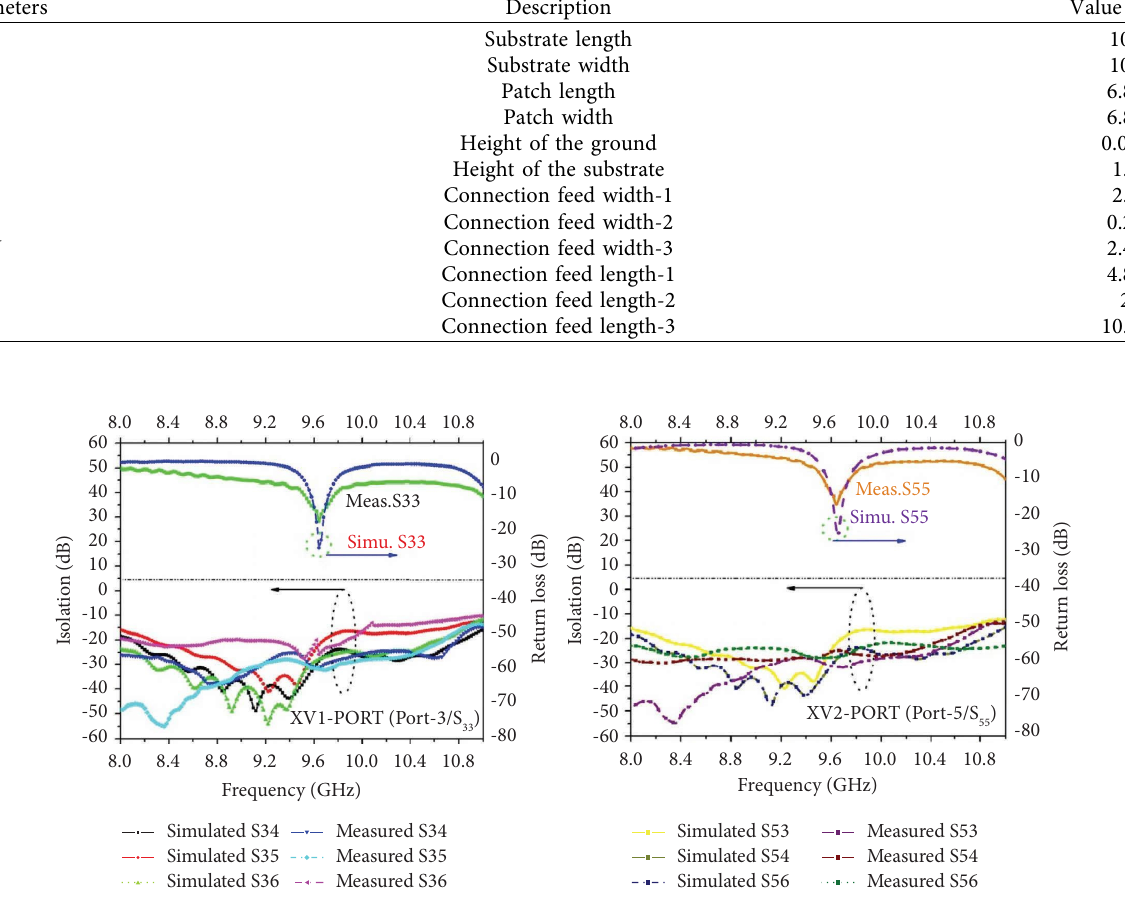
Figure 5: Frequency versus return loss and isolation of XV1 and